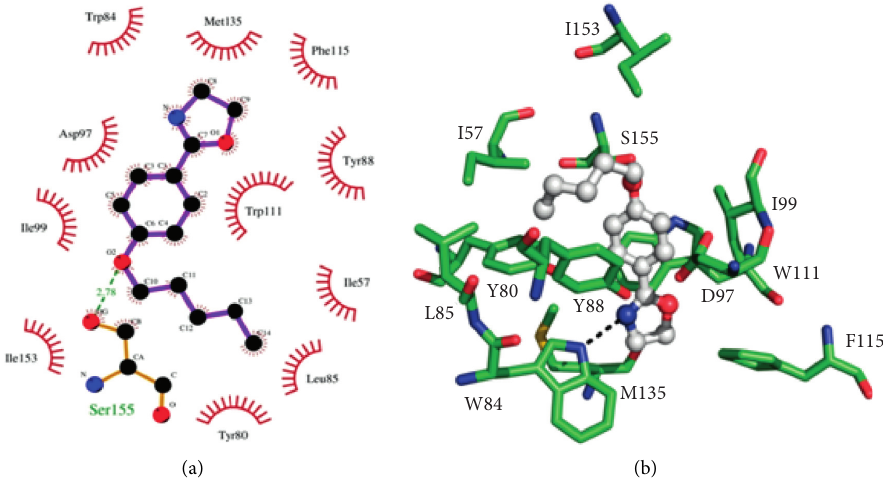
Figure 10: The interactions between oxazoline 16 and CviR (a) in a 2D schematic diagram and (b) in